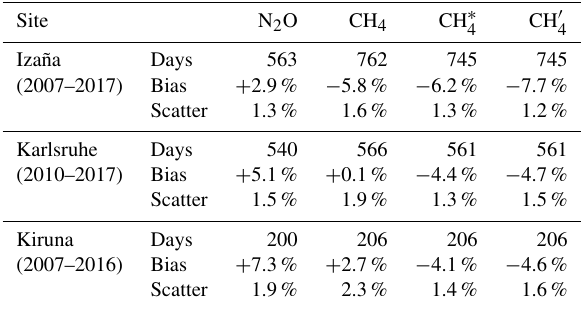
Table 6. As Table 5, but for the difference with respect to NDACC FTIR data (MUSICA IASI − NDACC FTIR) at the three sites of Tenerife, Karlsruhe and Kiruna and for retrievals at 4.2km.